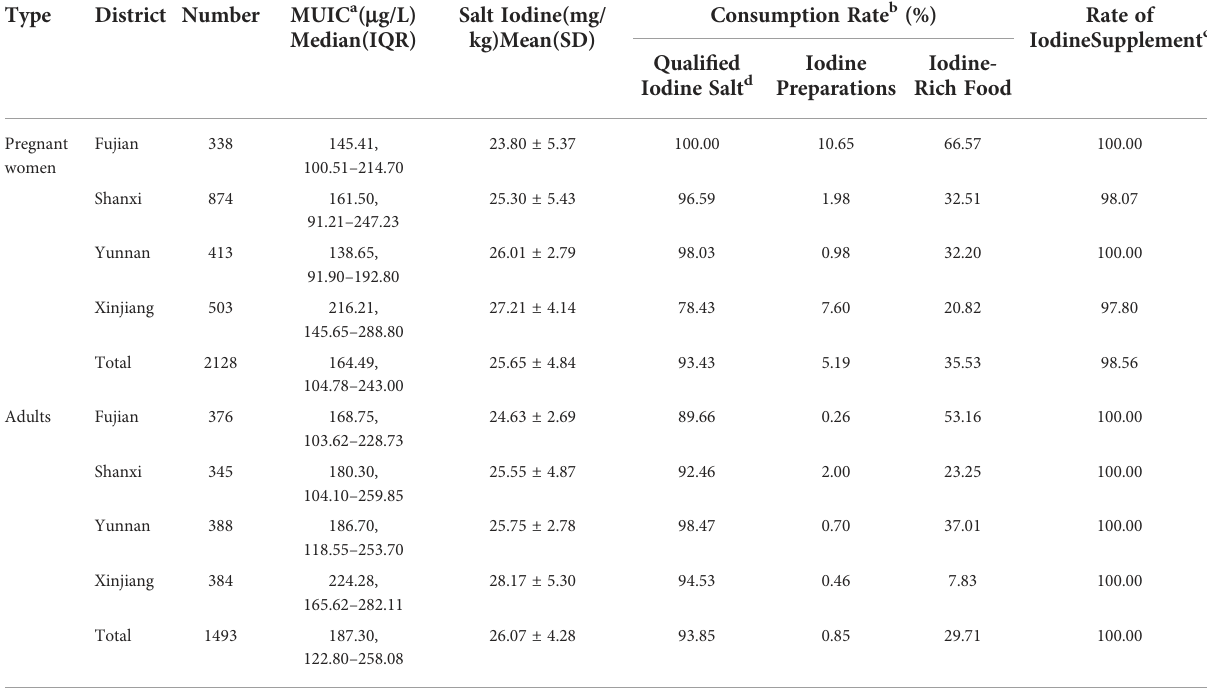
TABLE 2 The iodine supplement situation of adults and pregnant